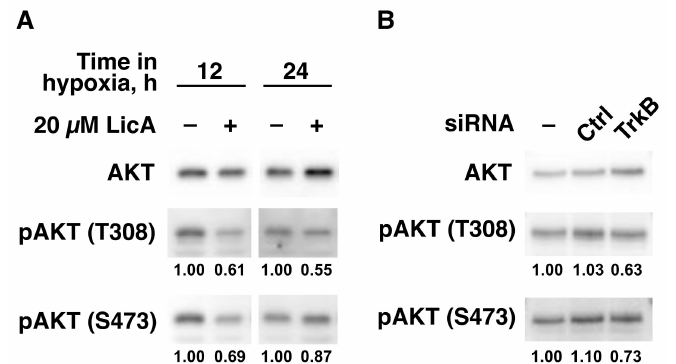
Figure 3. Inhibitions of TrkB-downstream AKT activation in SK-N-SH by LicA. ( A ) Cells (1 × 10 6 cells / 10 cm dish) were cultured in hypoxia for the indicated periods with 20 µ M LicA. AKT protein and its phosphorylated forms (pAKT) at Thr308 (T308) and Ser473 (S473) were determined by immunoblot. The ratios of pAKT(T308) and pAKT(S473) levels to AKT level were expressed as relative values to untreated control. ( B ) Cells (2 × 10 5 cells / 10 cm dish) were cultured in normoxia for 24 h and transfected by indicated siRNA in hypoxia for 48 h. The levels of pAKT(T308) and pAKT(S473) proteins were determined by immunoblot and expressed as described in ( A